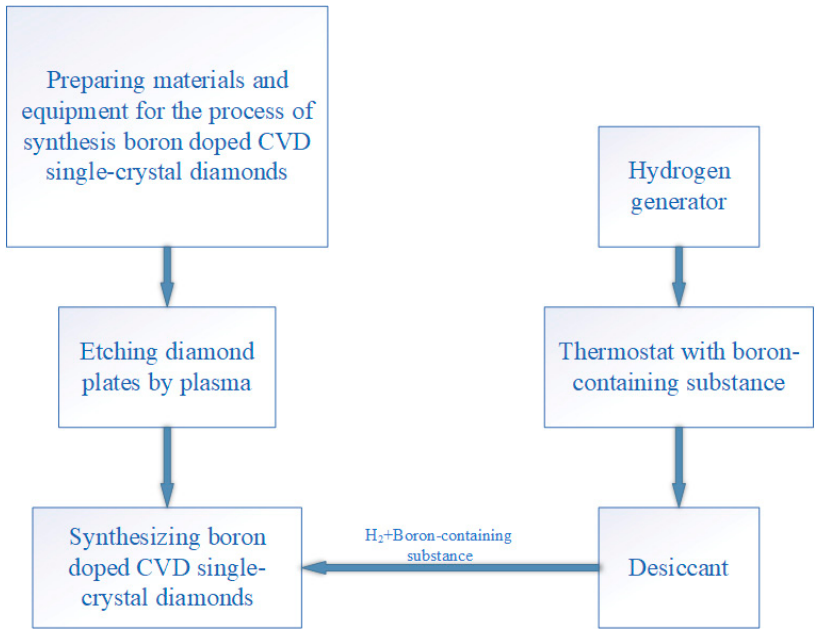
Figure 3. Schematic diagram of the technology of preparing single-crystal diamond substrates for doping and the doping process itself.